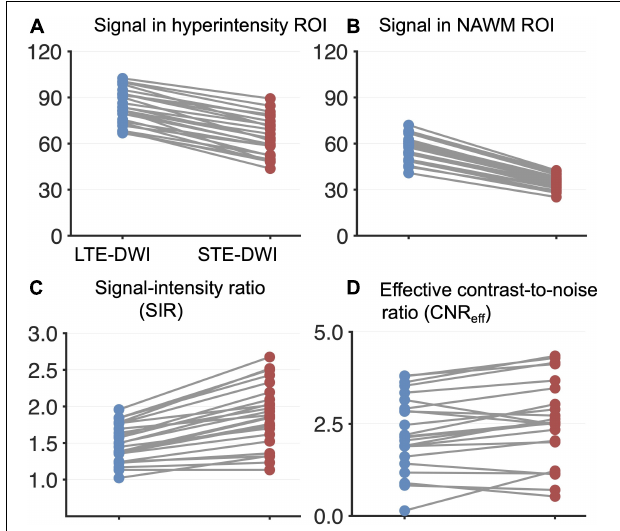
FIGURE 3 | Quantitative analysis of LTE-DWI and STE-DWI at a b -value of 2,000 s/mm 2 from 25 patients (each patient contributes with one pair of data points). Panel (A) shows signal differences of LTE-DWI (blue dots) and STE-DWI (red dots) in the hyperintensities. Panel (B) shows the corresponding results for the NAWM. Panel (C) shows the signal intensity ratio (SIR). Panel (D) shows CNR eff . Both the SIR and CNR eff were significantly higher with STE-DWI than LTE-DWI (see main text for details).